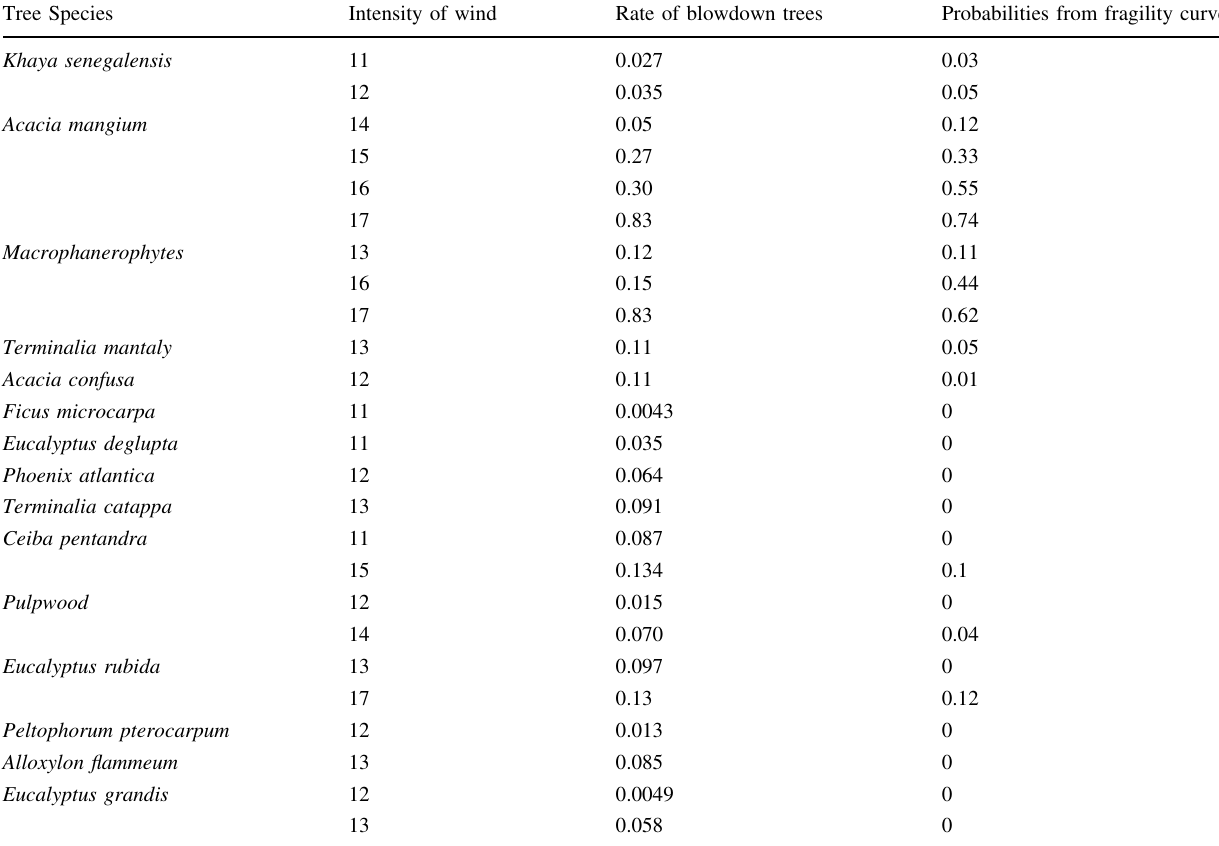
Table 3 Comparison of historical rate of blowdown trees with probabilities from fragility curves Tree Species